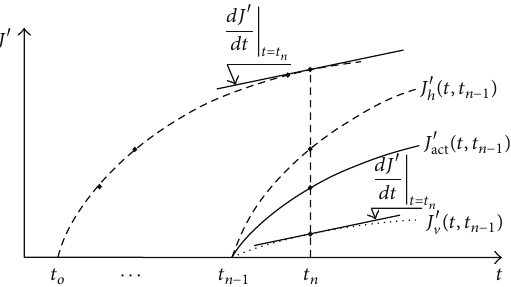
Figure 2: Concept of the two-way creep